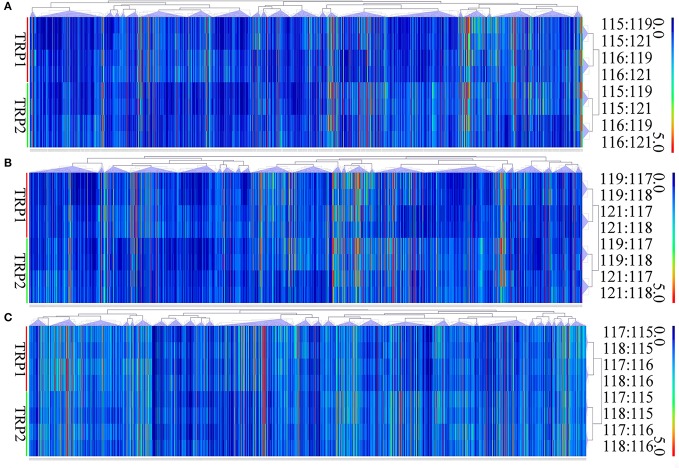
Hierarchical clustering of DEPs of O vs. T, T vs. C and C vs. O. Expression values were log2-transformed. TRP1 and TRP2 represent biological replicates 1 and 2. (A–C) represent hierarchical clustering of DEPs for O vs. T, T vs. C and C vs. O, respectively. O, oocysts; T, tachyzoites; C, bradyzoites-containing cysts.